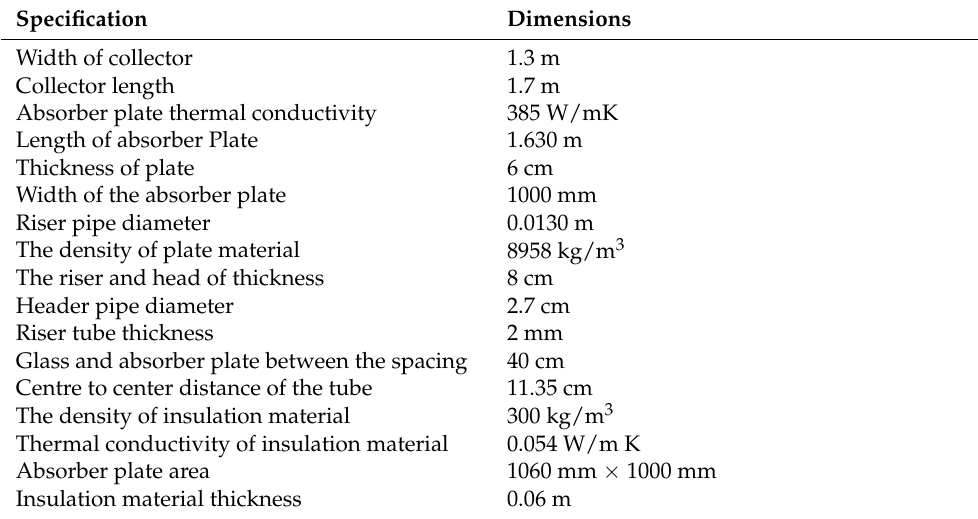
Table 2. The experimental setup